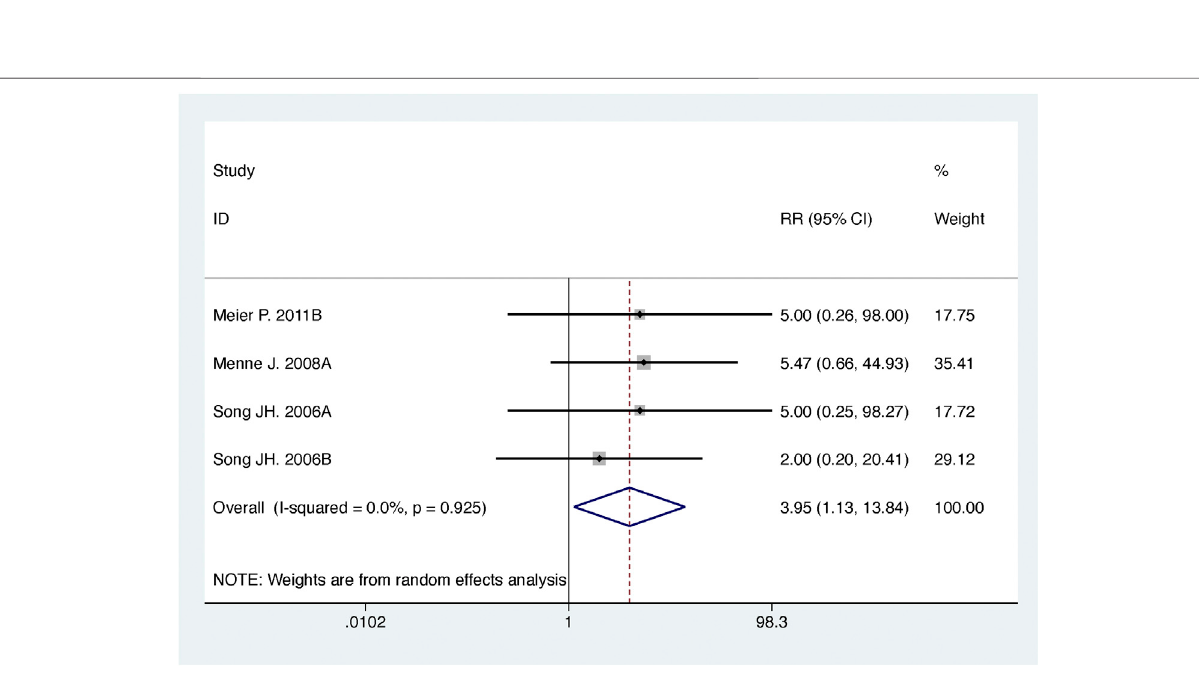
Frontiers in Pharmacology |